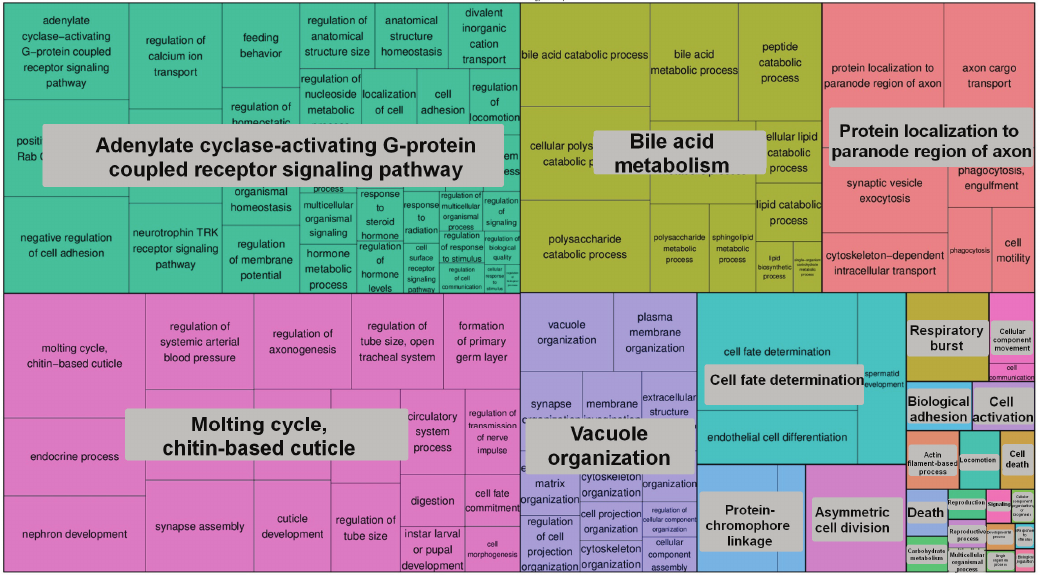
Figure 5. The GO terms (biological process) that were enriched for genes prone to 5-hmC modification. The areas of rectangles are proportional to the relative increase in frequency of GO terms comparing genes that had 5-hmC related peaks to genes that completely lacked them. The corresponding quantitative data and a full list of GO terms can be found in Supplementary File S1.